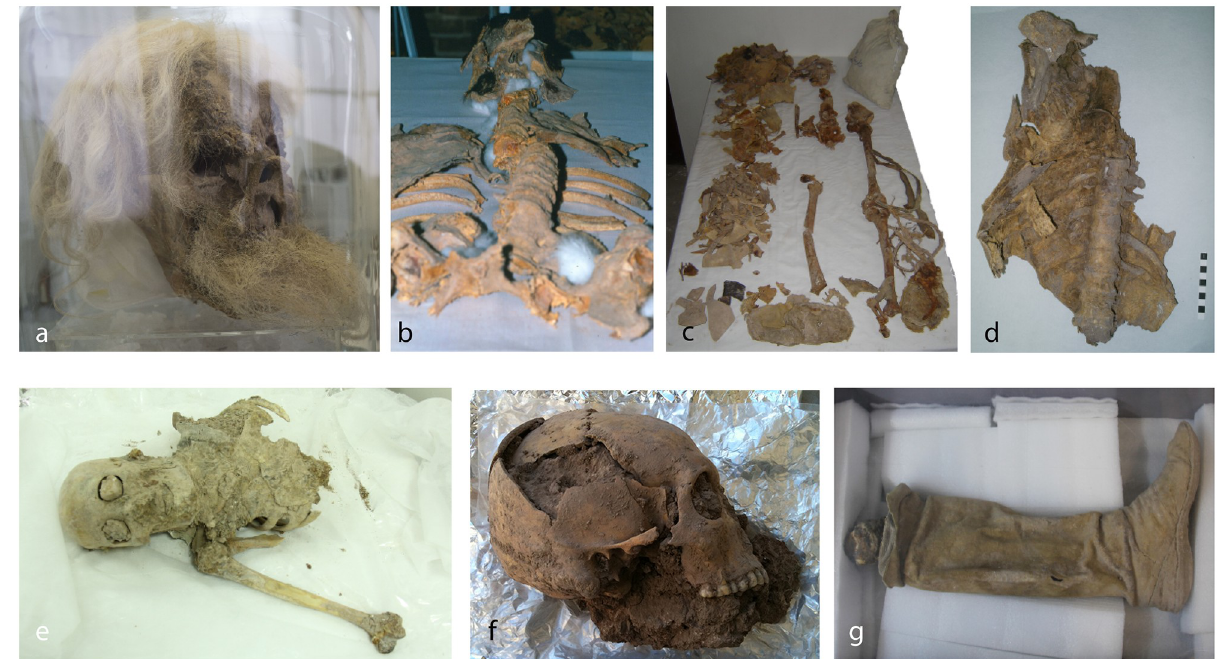
Fig 2. a-g: Photos of the salt mummies; a) SM1; b) SM2; c) SM3; d); thorax found nearby of SM1; e) SM5; f) SM6; g) leather shoe with lower leg, likely belonging to SM1, SM7 or SMX. Photos taken by Frank Ru¨hli (e, f, g), Abolfazl Aali (b, c) and Lena O¨hrstro¨m (a, d).